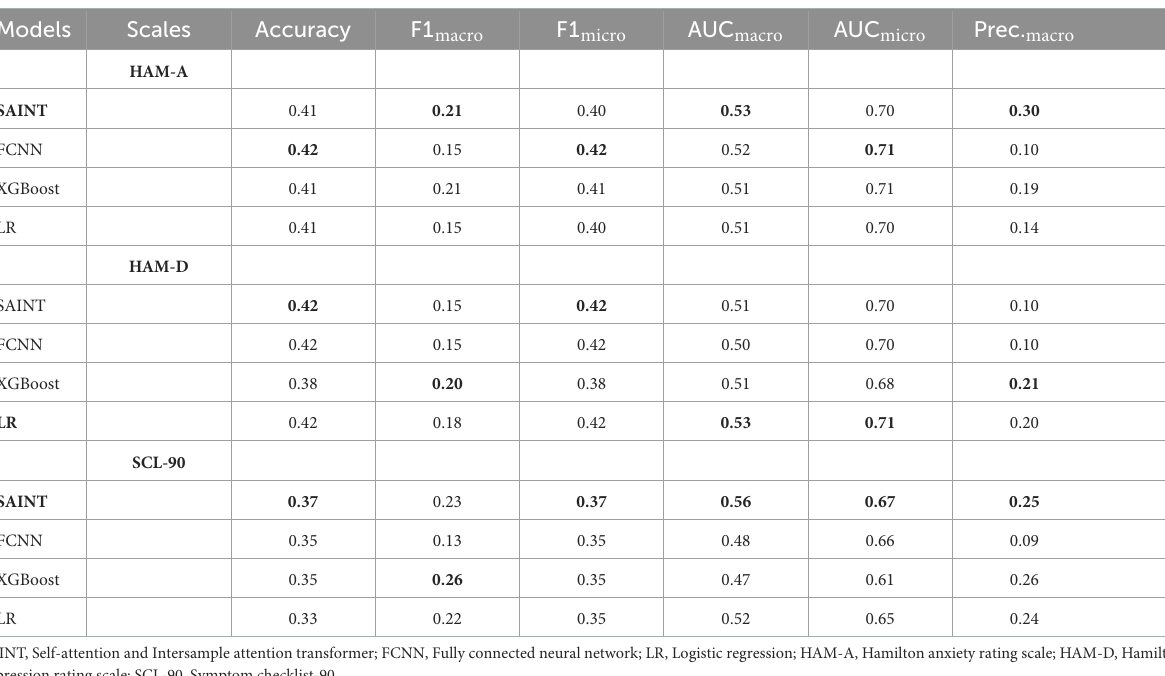
TABLE 6 Detailed performance of models.